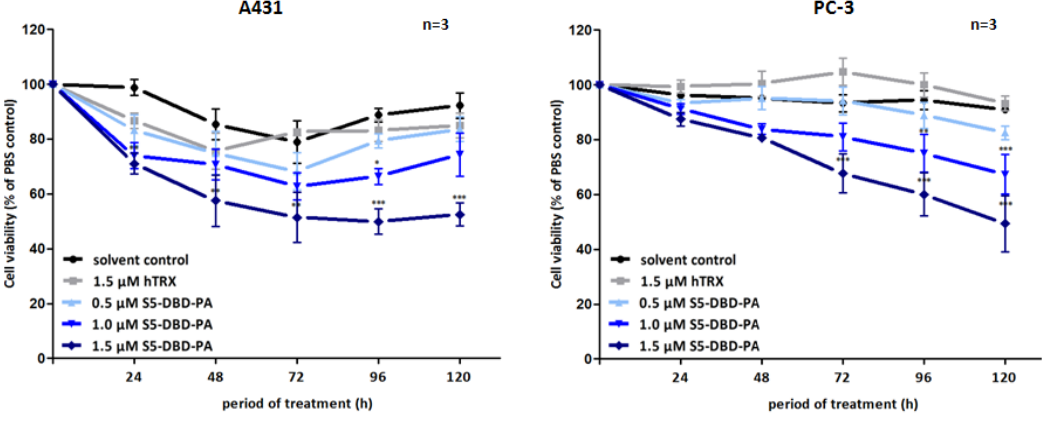
Figure 7. Suppression of tumor cell growth and viability by transduction of recombinant S5-DBD-PA. S5-DBD-PA was transduced into the four tumor cell lines A431, PC-3, T-47D and HCT116 by adding 0.5, 1, 1.5 µM of recombinant S5-DBD-PA to the culture medium. The treatment with the scaffold control protein (hTRX) in a 1.5 µM concentration as well as with the same volume of protein-solvent (dialysis buffer) and PBS served as negative controls. Medium and peptides were replaced daily and cell viability and concomitant growth was determined by XTT assay. Results are shown as the percentage of viable cells compared to the PBS control. (n = 3; Ø ± SD) Significantly reduced XTT-values in comparison to protein-solvent treated cells are indicated. * p < 0.05, ** p < 0.01, *** p < 0.001 (2-way-ANOVA with Bonferroni